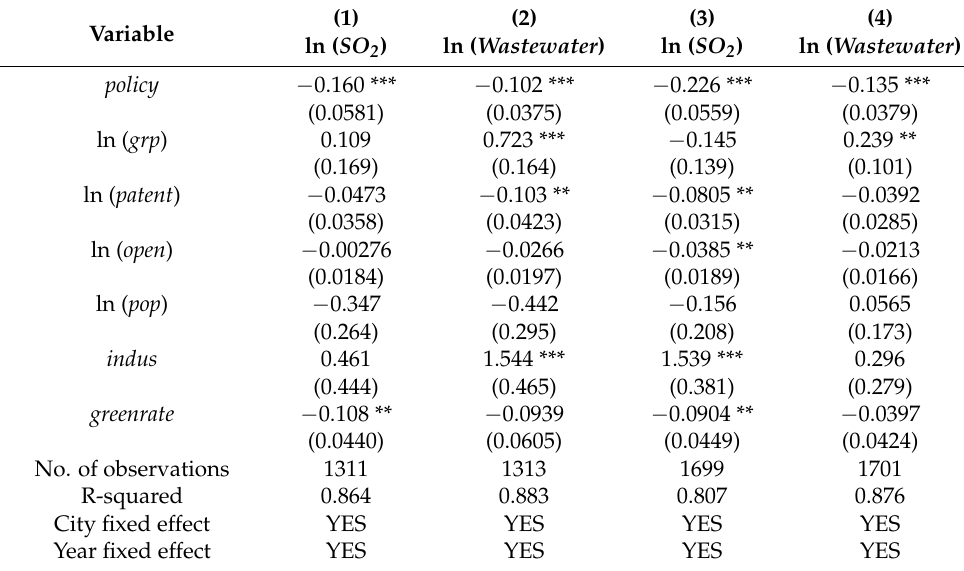
Table 6. Robustness checks—sample